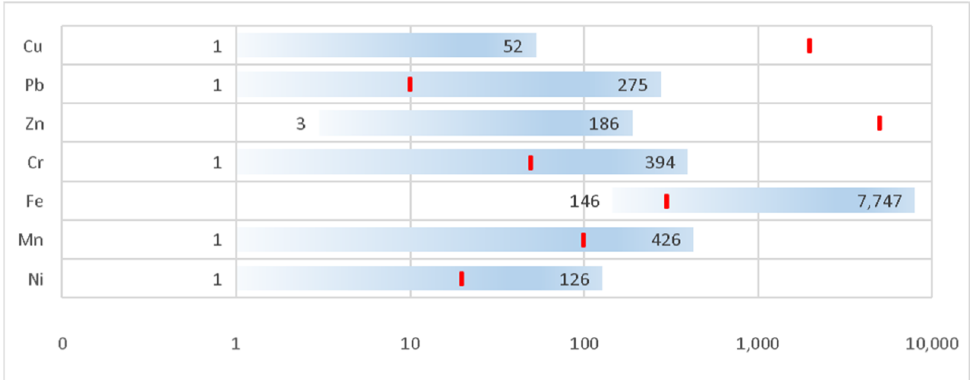
Figure 6. Range of concentrations sampled in groundwater in wells PM1, PM2 and PM3 of the infiltration swale soil in 2015–2017. Concentrations are in mg/L. The red line indicates the chemical concentration for the Brazilian reglatory limit (BRL) for groundwater [54].